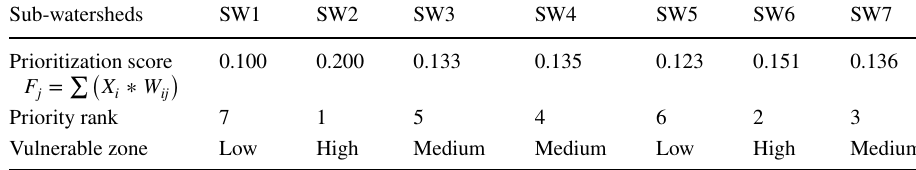
Table 7 Prioritization values and